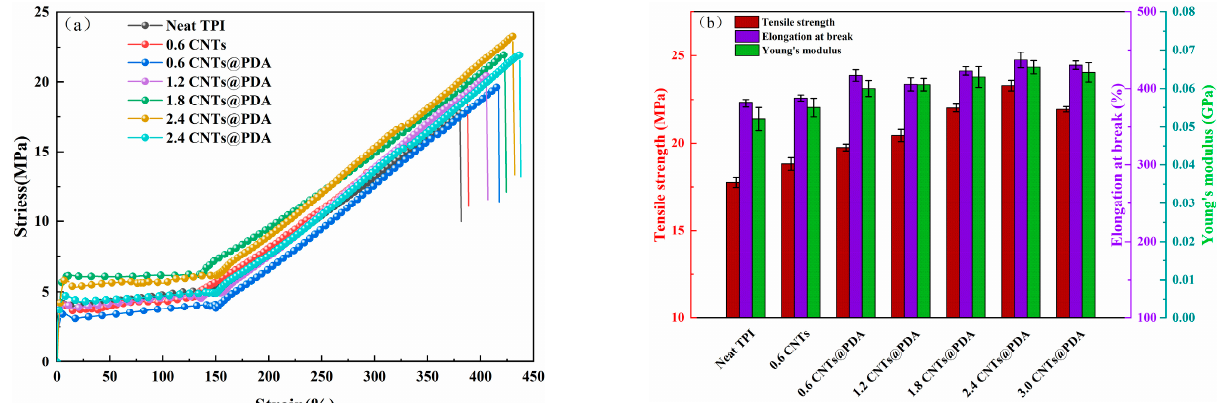
Figure 10. ( a ) Stress–strain curves; ( b ) average stress, elongation-at-break and Young’s modulus of TPI composites with various CNTs@PDA hybrid loadings.